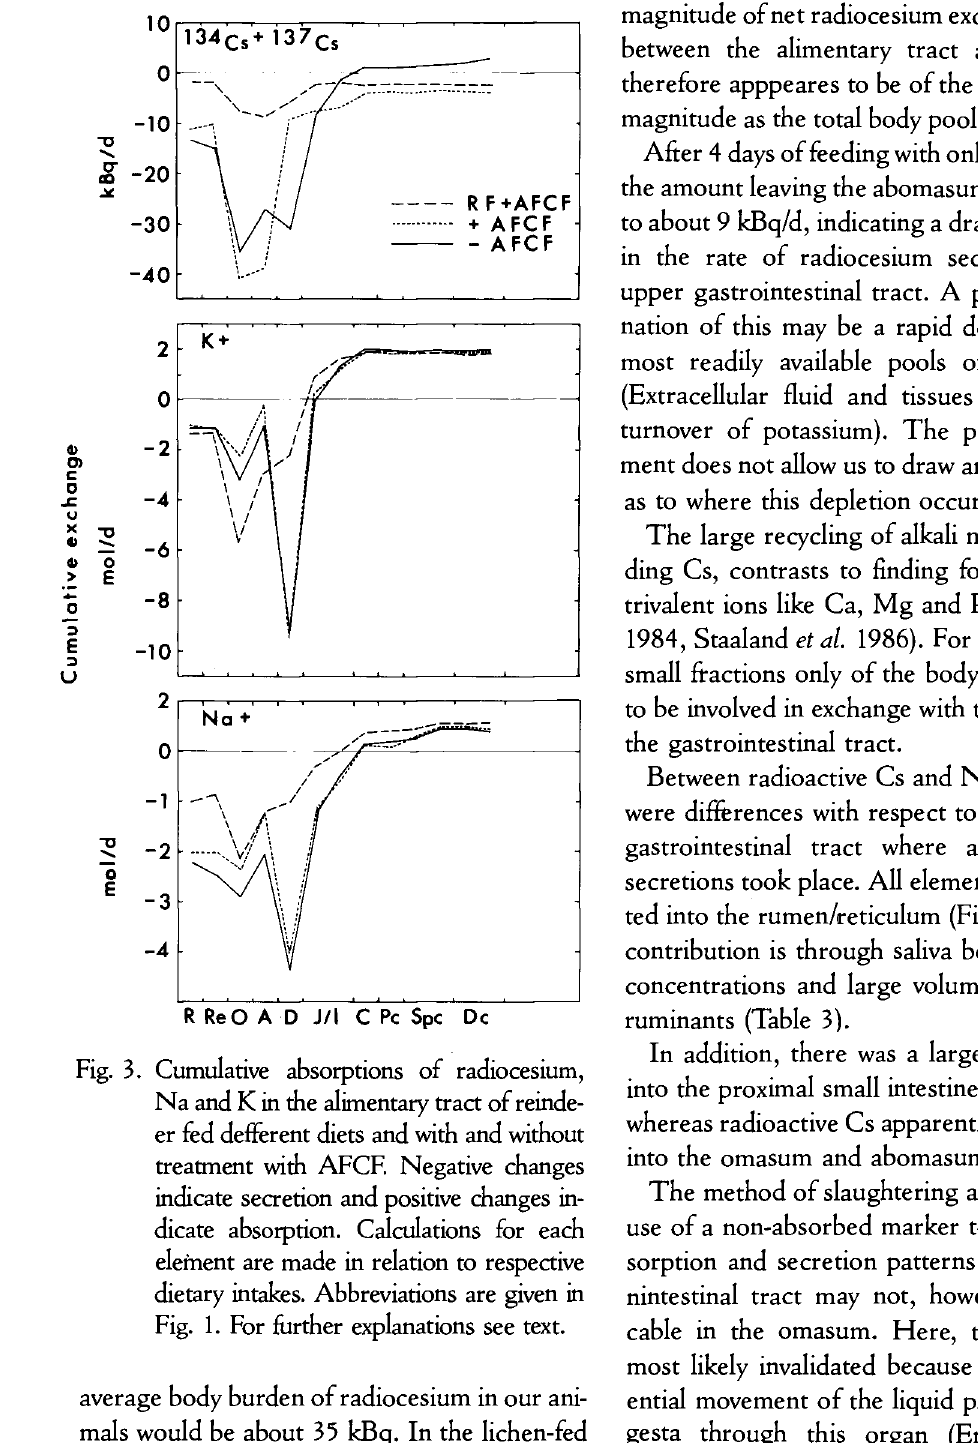
Fig. 3. Cumulative absorptions of radiocesium, Na and K in the alimentary tract of reinde er fed defferent diets and with and without treatment with AFCF. Negative changes indicate secretion and positive changes in dicate absorption. Calculations for each element are made in relation to respective dietary intakes. Abbreviations are given in Fig. 1. For further explanations see